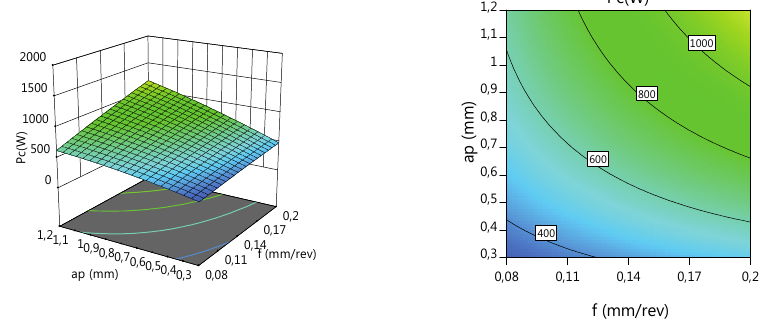
=245m/min c power, with cutting speed VEffect of depth of cut and feed rate on cutting Fig.